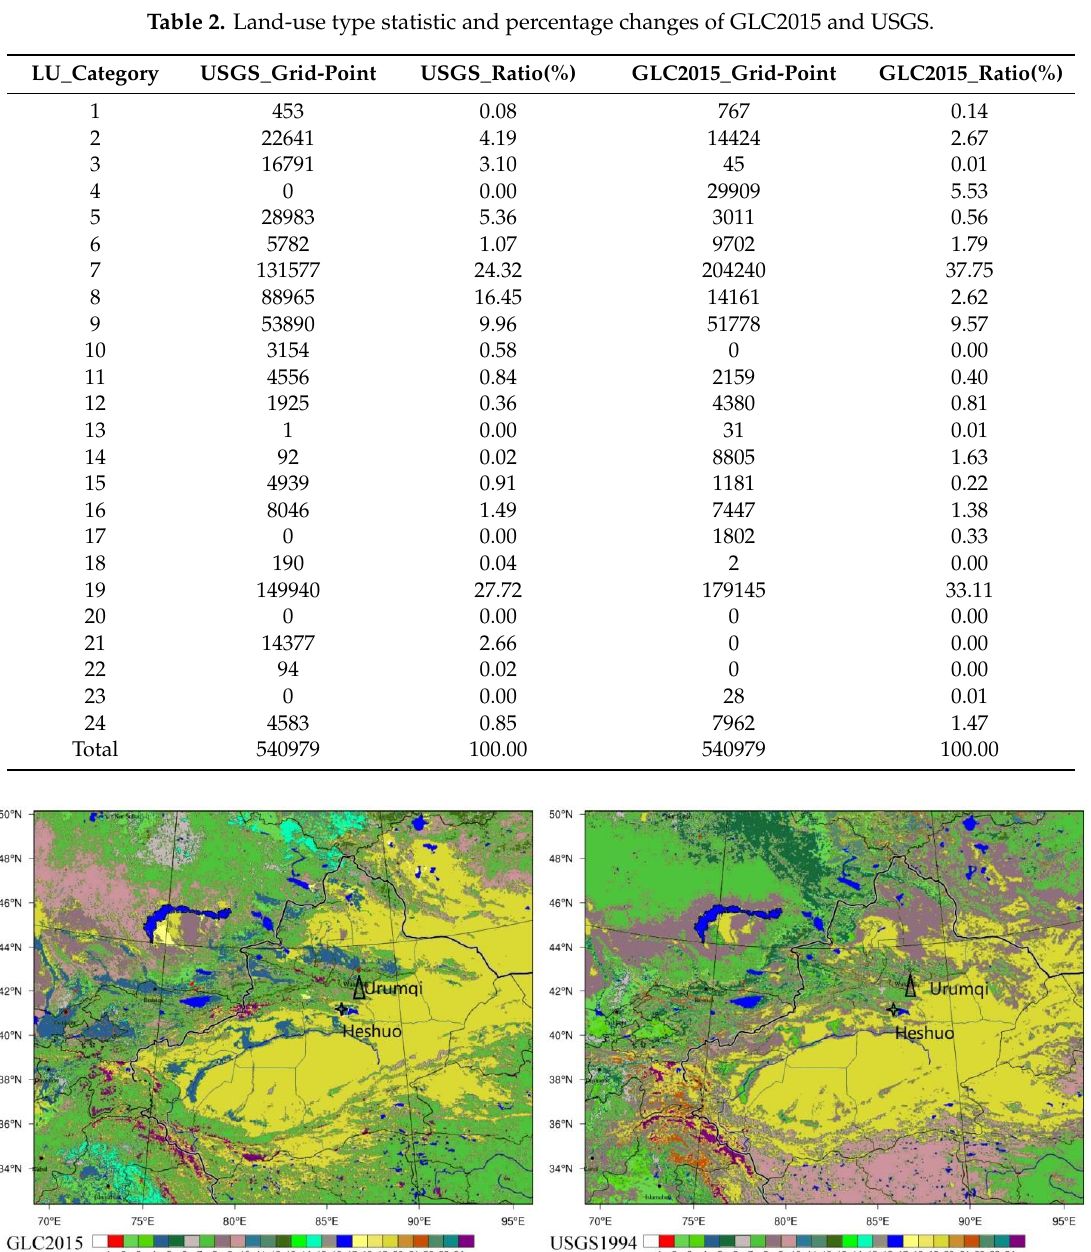
Figure 3. LU_INDEX (Land use Index) maps of the GLC2015 and USGS land-use data.